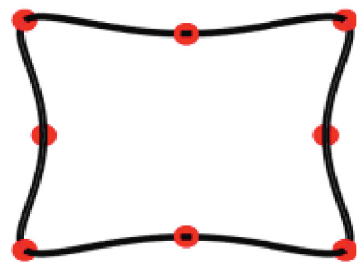
Figure 14: Sequence of